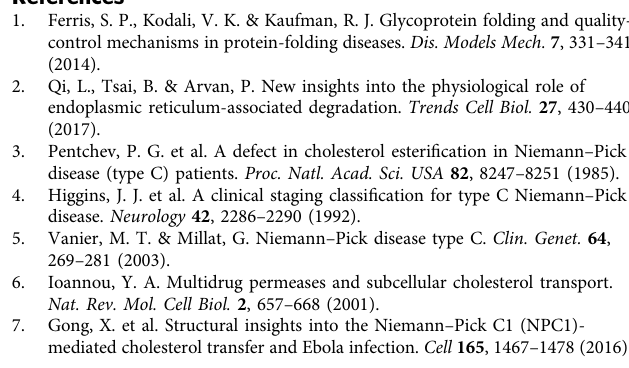
Supplementary Fig. 4b (Product number and targeting sequence: 1# J-016936-18, AGUUGUAGACUUAGGCUUA; #2 J-016936-19, UCAGAAGAAACGUGA GAGA; #3 J-016936-20, GAGAGUGAAUUGGGACUUA; #4 J-016936-21, CCGAAAUUAUCAAGGUAUC). siRNAs were transfected using TransIT-X2